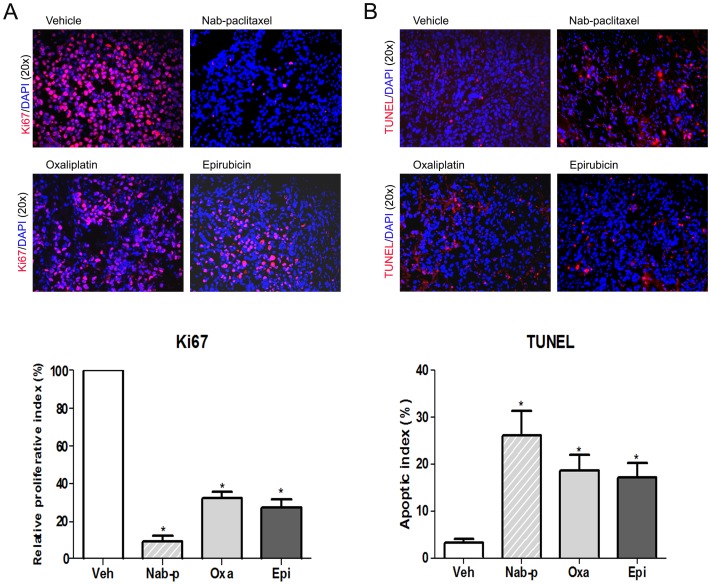
Effects of nab-paclitaxel treatment on cell proliferative and apoptotic activity in vivo.SCID mice were subcutaneously injected SNU16 cells (20×106) and treated with nab-paclitaxel for 2 weeks. (A) Intratumoral proliferation was measured by immunostaining tissue sections with Ki67 nuclear antigen followed by fluorescent microscope photography. Ki67-positive cells were counted in five high power fields per sample. Fold change in proliferative index was standardized to controls (set to 1) and other samples are compared relative to this sample. (B) Intratumoral apoptosis was measured by staining tumor tissue section with the TUNEL procedure and subsequent fluorescent microscope photography. TUNEL-positive apoptotic cells were counted in five high power fields per sample. For both immunostaining experiments, each group had at least three samples counted and the data are expressed as the mean ± standard deviation. Symbol * represents significant difference compared to vehicle group (p<0.05).